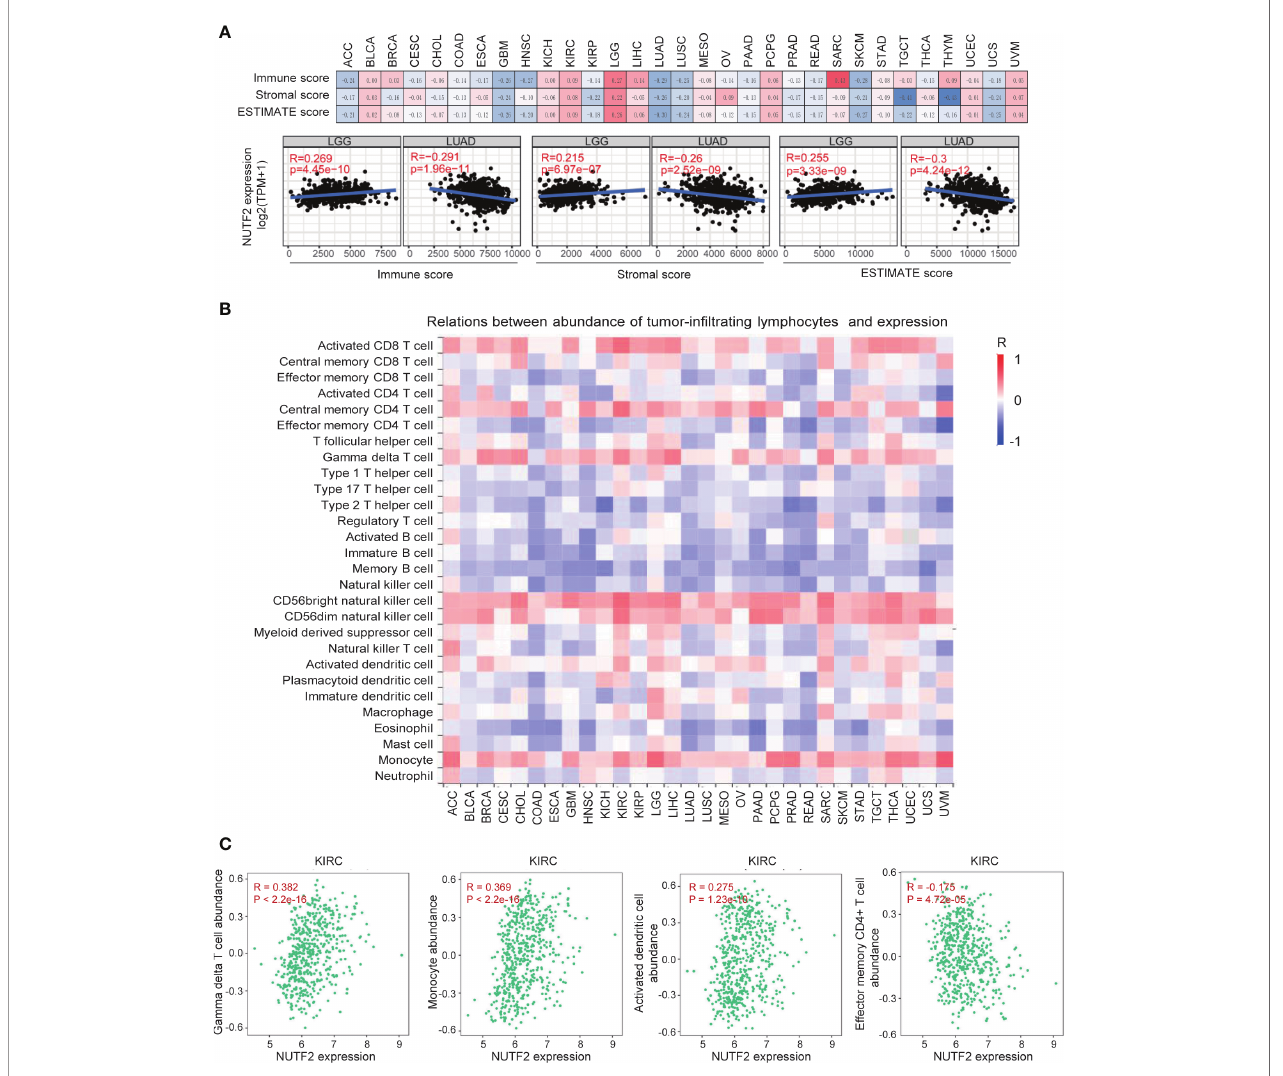
FIGURE 4 | Correlation analysis between NUTF2 expression and the abundance of tumor-in fi ltrating lymphocytes. (A) The potential associations between in fi ltrating stromal and immune cells and NUTF2 expression level were explored by ESTIMATE algorithm. (B) Correlation analysis between abundance of tumor-in fi ltrating lymphocytes and NUTF2 expression in different cancer types. (C) Correlation between NUTF2 expression and Tgd, monocyte, activated dendritic cells, and Tem CD4 + cell in fi ltration in